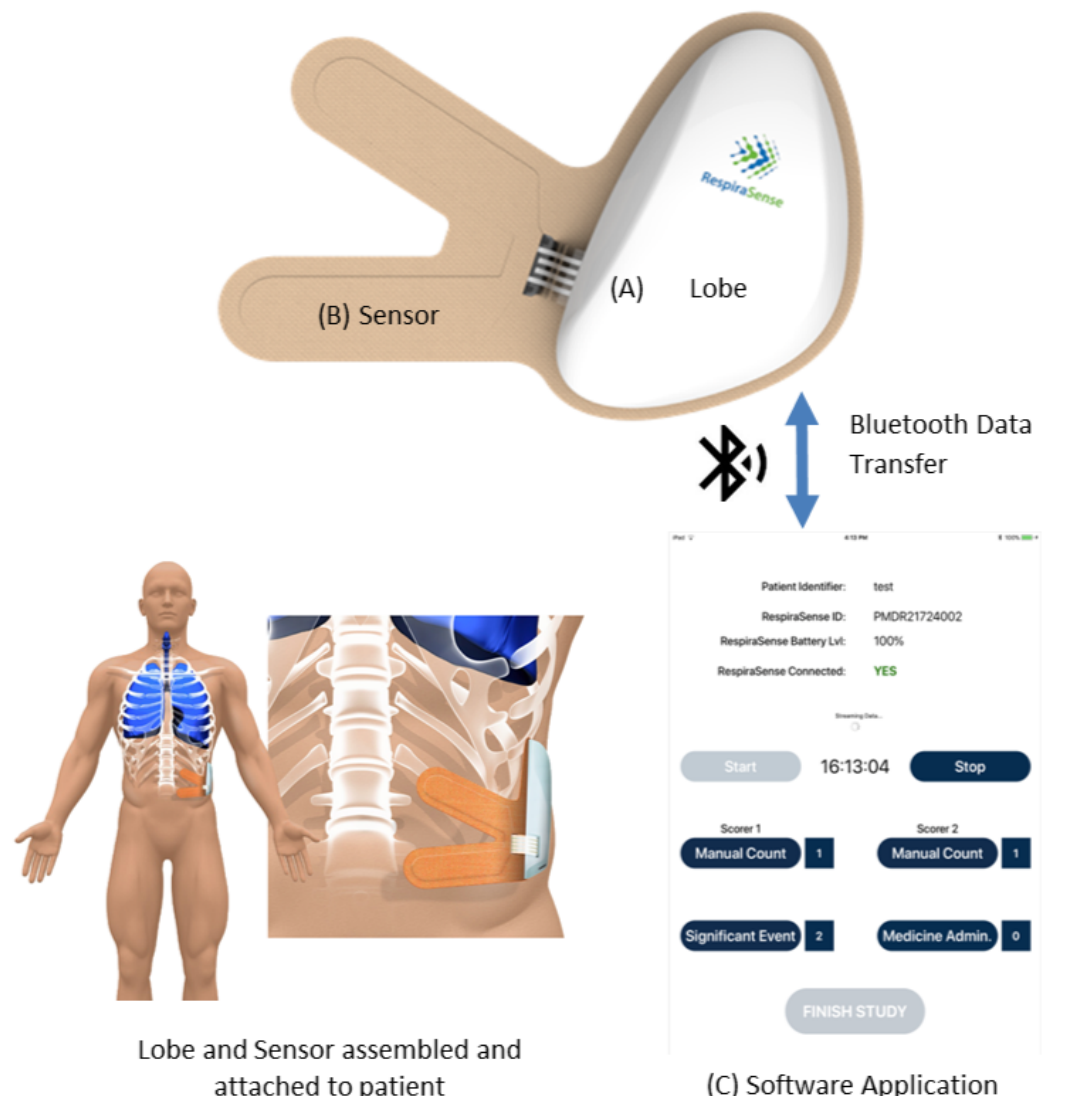
Figure 3. RespiraSense device and data